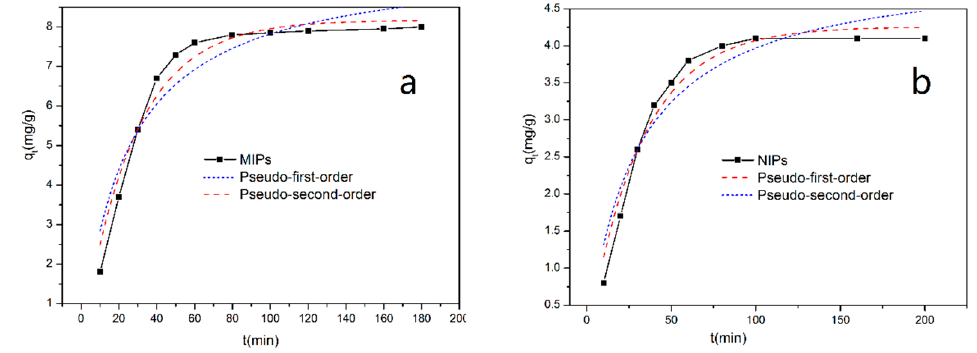
Figure 8. Adsorption kinetics fitting curves of MIPs ( a ) and NIPs ( b ) at 35 °C (10 mg of MIPs/NIPs in 5 mL of 0.3 mmol·L − 1 SMZ solution).